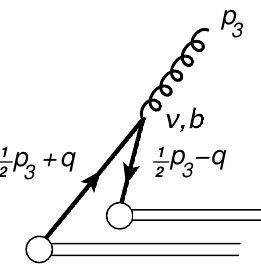
Figure 6 . Feynman diagram for the distribution amplitude for t (cid:22) t 8 T ! g at